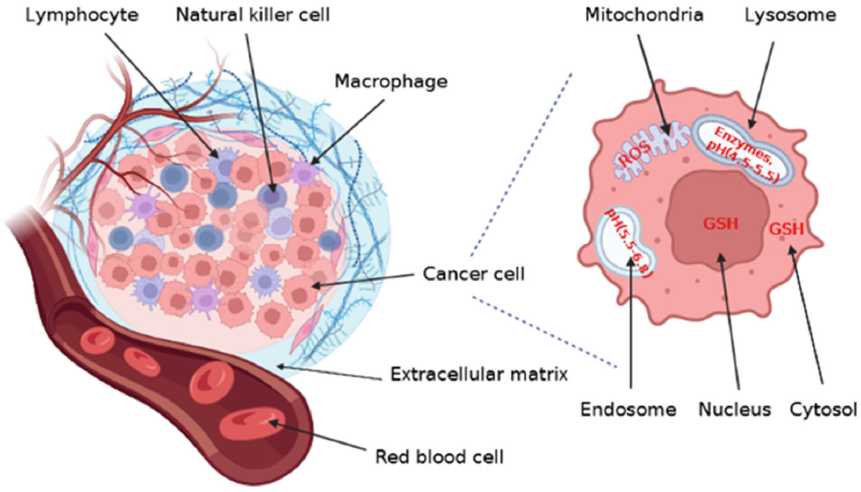
Figure 7. The tumor microenvironment and a cancerous cell—representing various endogenous